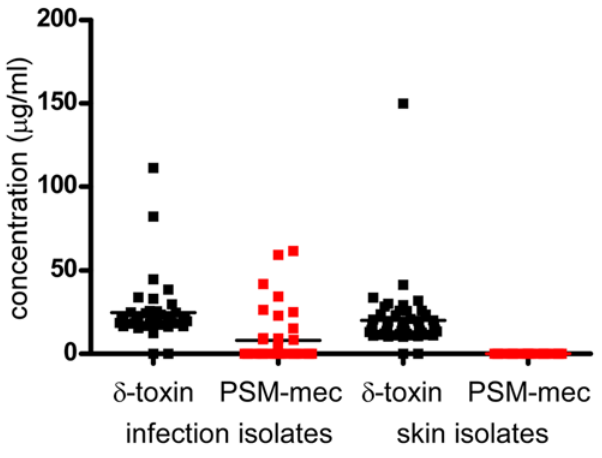
Figure 2. Production levels of PSM-mec in S. epidermidis infection and colonizing skin isolates. PSM-mec concentrations (at 8 h of growth) in S. epidermidis isolates from a Shanghai strain collection [19] obtained from the skin of healthy individuals without recent exposure to hospitals, or from S. epidermidis infections (mainly catheter-related, blood, and urinary tract infections) were determined by RP-HPLC/ESI-MS. Determined concentrations of d -toxin in the strains are shown in comparison.